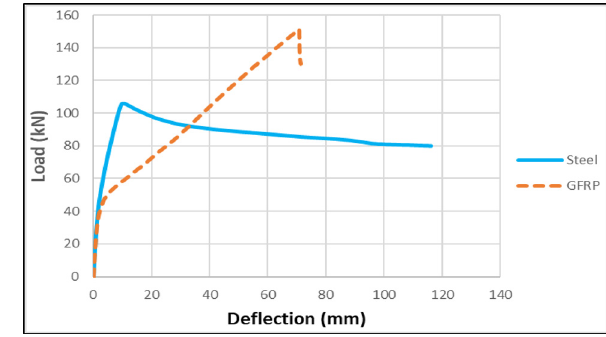
Figure 15: Load – de fl ection curve for specimens beams steel and